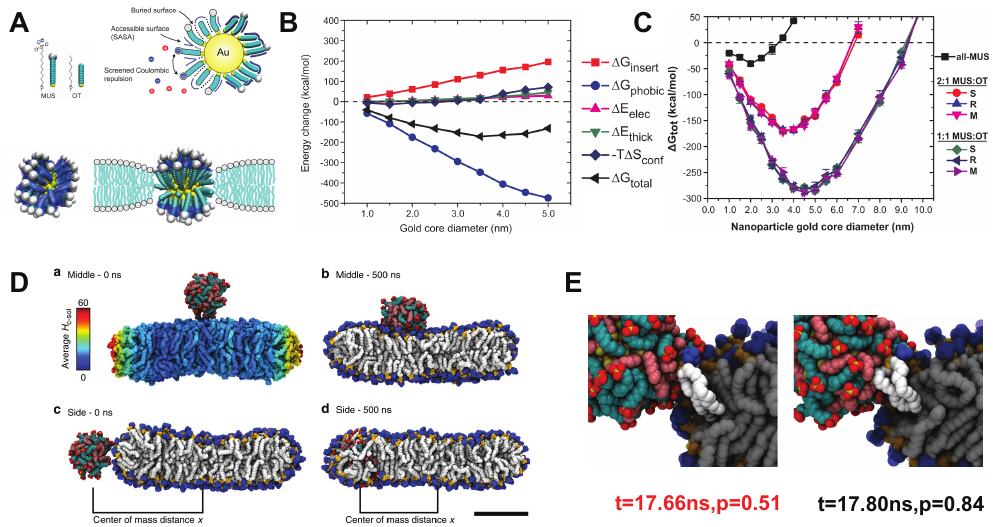
Figure 5. Free energy and kinetic barrier analysis for penetration of amphiphilic polymer-decorated NPs. ( A ) ( Upper part) Schematic of the solvent-accessible surface area (SASA), a parameter of the hydrophobic free energy, and electrostatic interactions; ( Lower part) comparison between the initial and final stable states of the amphiphilic polymer-decorated NPs. The hydrophilic ligands are squeezed out of the bilayer’s hydrophobic region, forming a so-called “snorkeling” phenomenon; ( B ) Decomposition of the free energy during the NP penetration process. ∆ G total is the total free energy change. ∆ G phobic is the change of hydrophobic energy, determined through the SASA. ∆ E elec is the electrostatic energy change. ∆ E thick is the free energy change corresponding to deformation of the lipid bilayer. ∆ S conf is the conformation entropy change of the decorated amphiphilic polymers; ( C ) Total free energy change ∆ G total as a function of NP diameter and monolayer composition. The ligand density on the Au NPs is kept constant; ( D ) Snapshots of the initial and final states of the NPs interacting with a lipid bilayer. For the case of 1:1 MUS:OT NP on the top of the bilayer, it cannot penetrate into the bilayer ( Upper part); while it can penetrate in the bilayer through the edge ( Lower part); ( E ) Snapshots of the transition states during NP penetration through the edge of a bilayer. At the transition time ( t = 17.66 ns), the protruding lipids were in contact with the amphiphilic NP. The figures are adapted from References [52,54,57,63] with